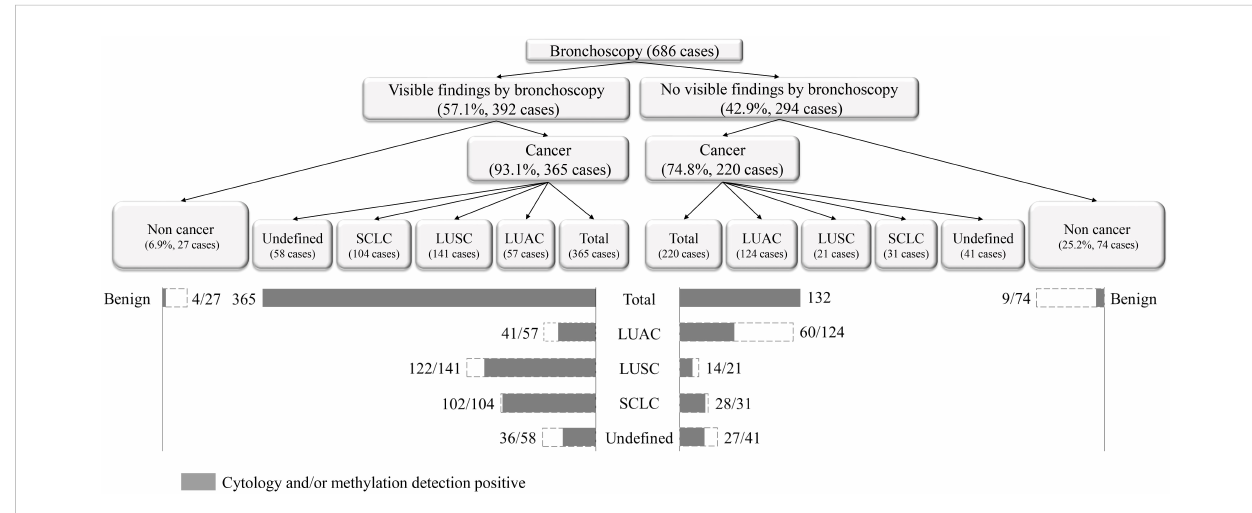
FIGURE 2 The comprehensive diagnostic process and result of morphological combined molecular methylation under